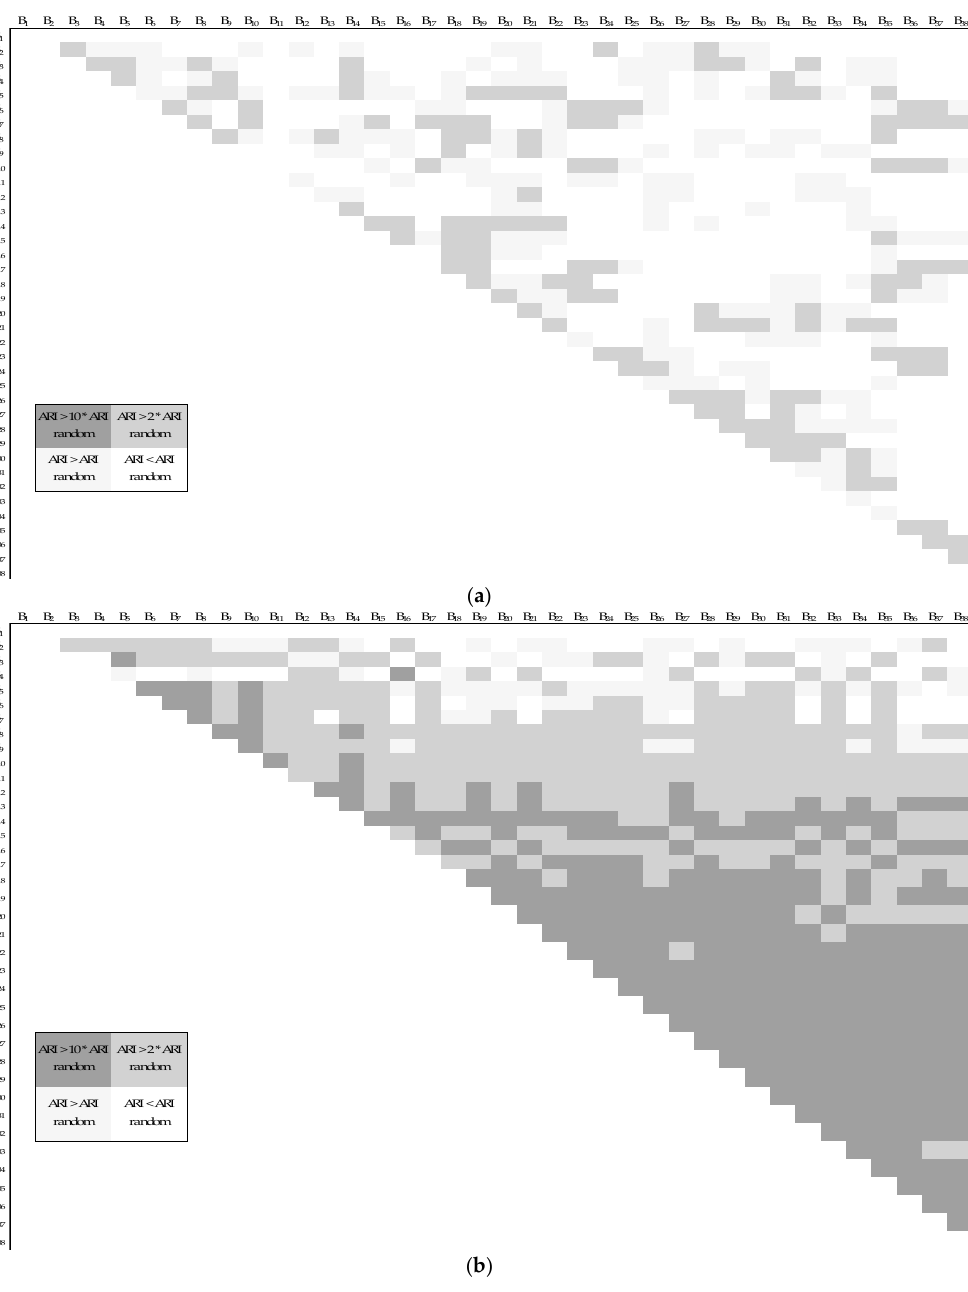
Figure A5. ARI results for 𝑚𝑖𝑛𝑆𝑒𝑟𝑖𝑒𝑠 set at 5% and window length 𝑤 set at 14 days (the short-term version is presented on the upper part ( a ) while the long-term version is on the bottom part of the figure ( b )).